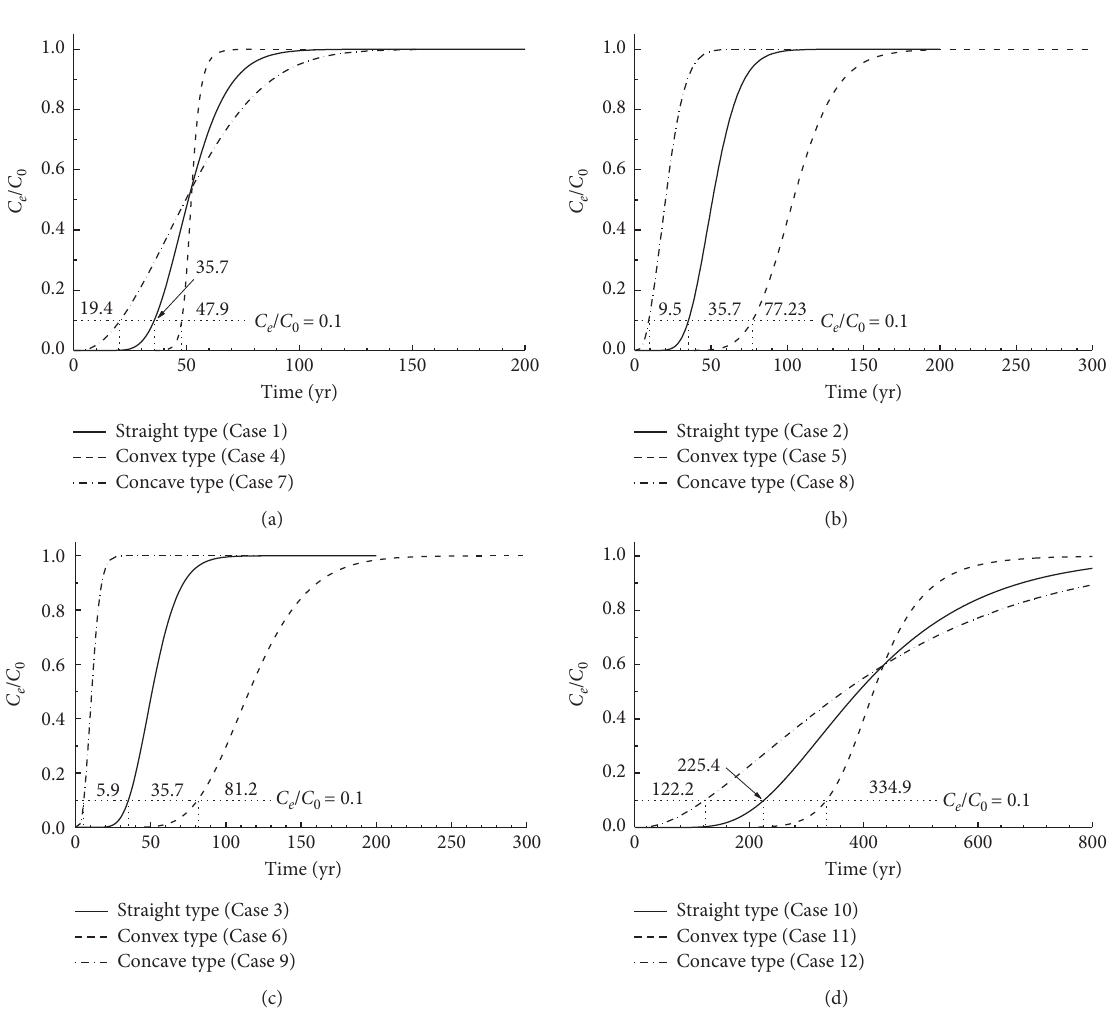
Figure 5: Comparison of the outflow concentration of different adsorption isotherms. (a) Cases 1, 4, 7 ( C ( C 0 � 100mg/L). (c) Cases 3, 6, 9 ( C 0 � 10mg/L). (d) Cases 10, 11, 12 ( C 0 �